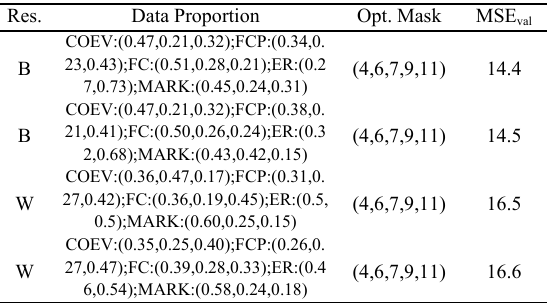
Table 10. Membership functions results obtained by the GA.